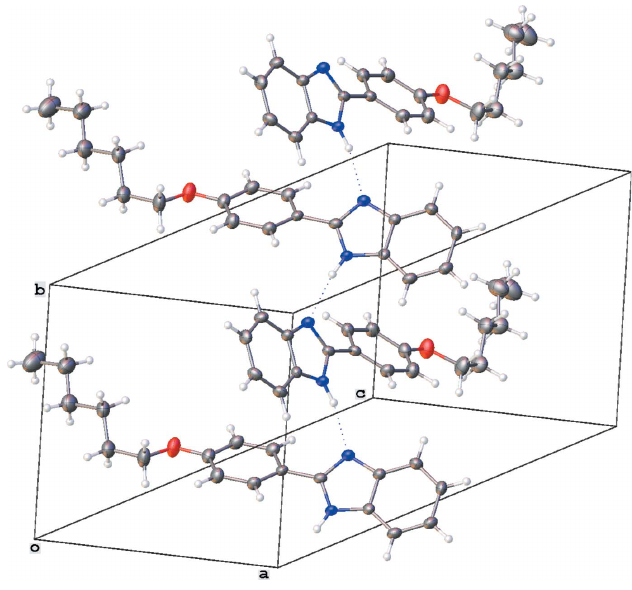
Figure 4 Hydrogen bonding in the crystal of 2-(4-hexyloxyphenyl)-1 H -benzimid- azole ( 1 ). Displacement ellipsoids are shown at the 50% probability